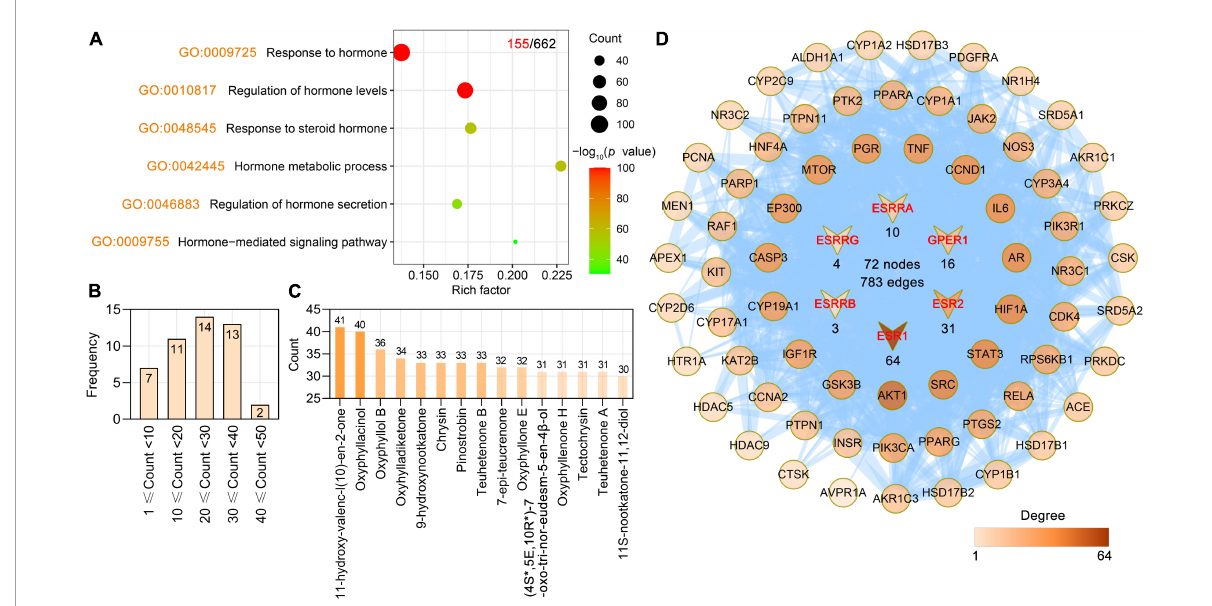
FIGURE3 Alpinia oxyphylla Miquel (AO) regulates hormone-related targets and their phytochemical components. (A) Bubble plot showing regulatory hormone-related BP terms in AO targets. The x -axis, rich factor (the ratio between the number of targets and the number of the background genes). Bubble size, the number of genes enriched. Bubble color, –Log 10 ( p -value). (B) Frequency distribution of AO phytochemicals corresponding to 155 hormone-related targets. (C) Number of AO phytochemical targets targeting 155 hormone-related targets. (D)